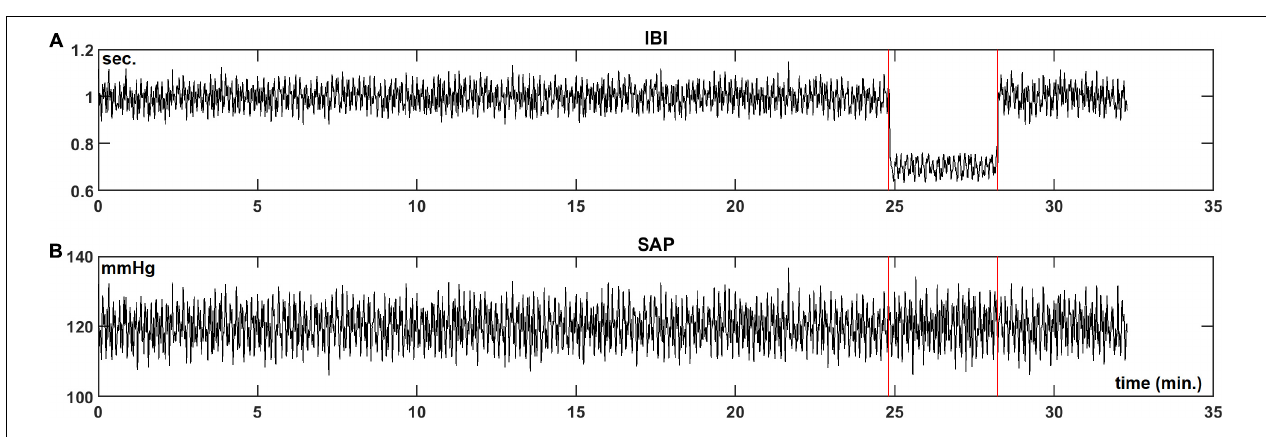
different time-frequency analysis method [SPWVD: